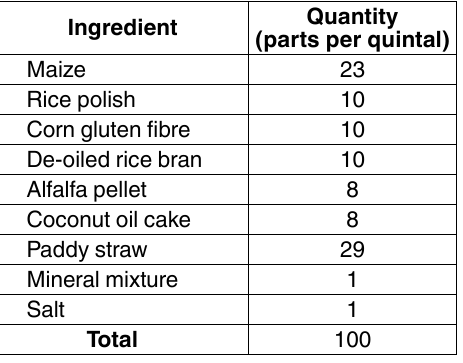
Table 1. Ingredient composition of total mixed ration used in IVGPT